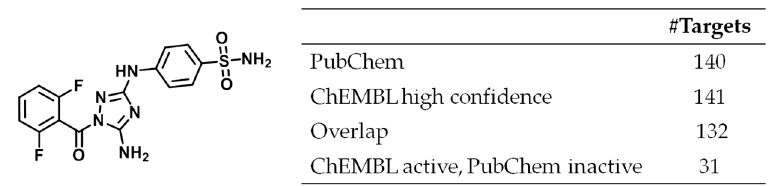
Figure 5. Highly promiscuous MTL. Shown is a compound (PubChem_CID 5330790, CHEMBL191003) with activity against 141 ChEMBL targets (high confidence data) that was tested against 132 of these targets in screening assays and reported to be active against 101 targets.